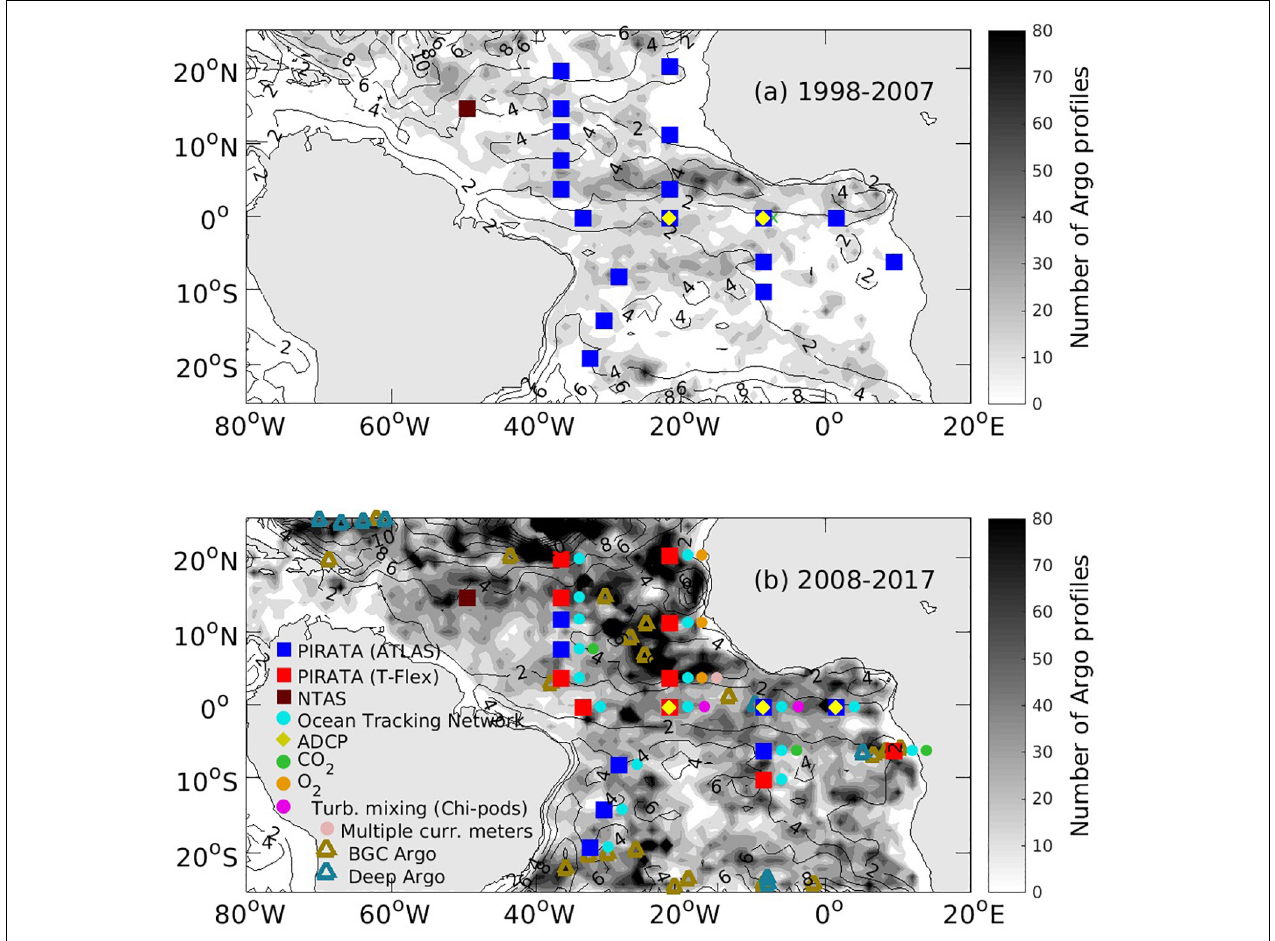
FIGURE 2 | Key elements of the tropical Atlantic in situ observing system during (a) 1998–2007 and (b) 2008–2017. Gray shading represents the number of Argo profiles made in each 1 ◦ box. Contours show the average number of hourly surface drifter observations made in each 1 ◦ box per month. Squares show moored buoy locations, circles indicate additional measurements made from the moorings, and triangles show locations of deep Argo and biogeochemical Argo floats during September